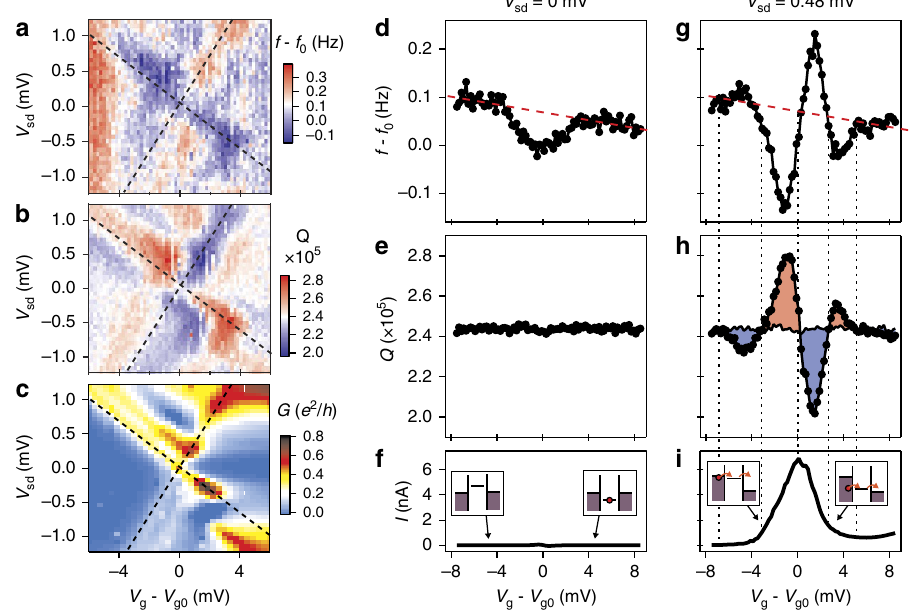
Figure 3 | Backaction effects as a function of QD bias conditions. ( a – c ) Colour plots of frequency shift f (cid:3) f 0 , quality factor Q and differential conductance G as a function of V sd and V g . These plots correspond to the V sd and V g region as indicated by the blue square in Fig. 1e and V g0 ¼ (cid:3) 0.465V is the gate voltage at which the Coulomb peak is positioned, where the dashed lines indicate the Coulomb diamond. ( d – i ) Comparison of the mechanical backaction effects between V sd ¼ 0mV ( d – f ) and V sd ¼ 0.48mV ( g – i ). In V sd ¼ 0mV, a linear f -shift, as indicated by the dashed line, as well as a f -dip at V g ¼ V g0 is observed, whereas no deviation is found in the corresponding Q -factor as I ¼ 0. At finite V sd , both frequency and Q -factor are modulated around the Coulomb peak, indicating the presence of a backaction force from the local charge state in the QD. Red (blue) area in h highlights the enhancement (suppression) of Q -factor. Schematics in ( f , i ) depict the corresponding energy diagram in the QD and the leads. In f , the relevant single electron level is above (below) the unbiased electrochemical potential when V g o V g0 ( V g 4 V g0 ). In i , the electron energy level moves across the electrochemical potential in the source (drain) electrode when V g o V g0 ( V g 4 V g0